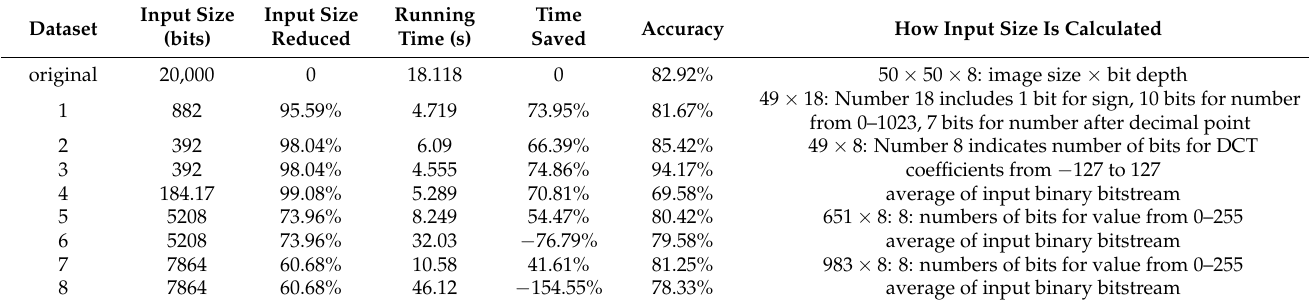
Table 5. Storage and time saved for all datasets. The trade-off can be made between lower accuracies with fewer computational resources (compression domain data), and higher accuracies with more computational resources (original